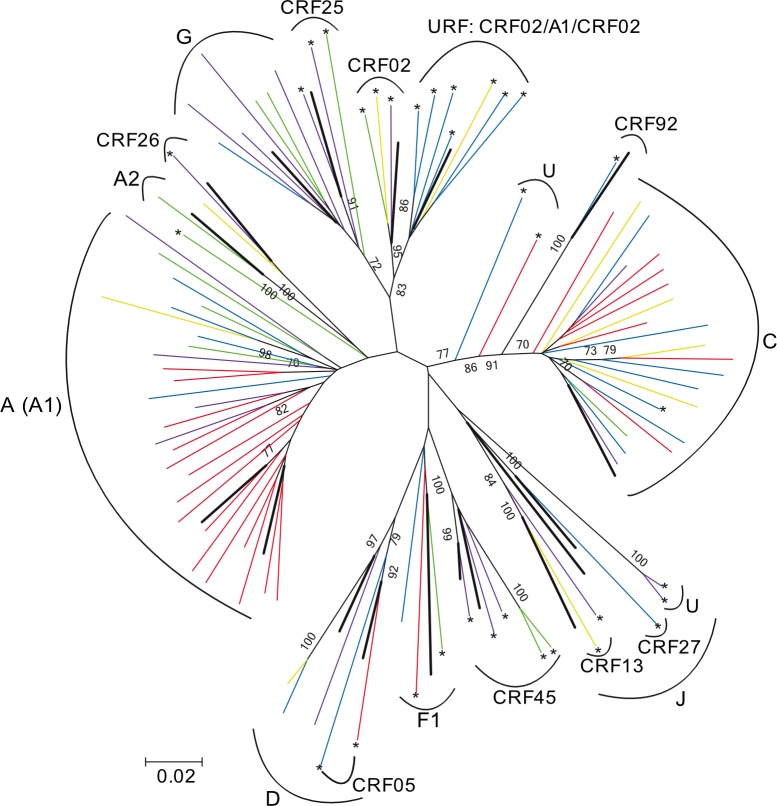
Maximum-likelihood phylogenetic analysis of aligned nucleotide sequences on the HIV-1 pol (HXB2 2133–3445 nt).Different geographic locations are color-coded as follows: blue, Mbuji-Mayi; yellow, Lubumbashi; green, Kinshasa; red, Goma; purple, Kananga, Bukavu, Mbandaka, Kindu, Matadi, and Kisangan. Sequences were aligned with HIV-1 M subtypes and recombinants reference sequences. Reference strains are represented by thicker lines, and the recombinants identified using the REGA V3 subtyping tool are indicated with an asterisk (*). Only bootstrap values >70 are indicated above the branches.